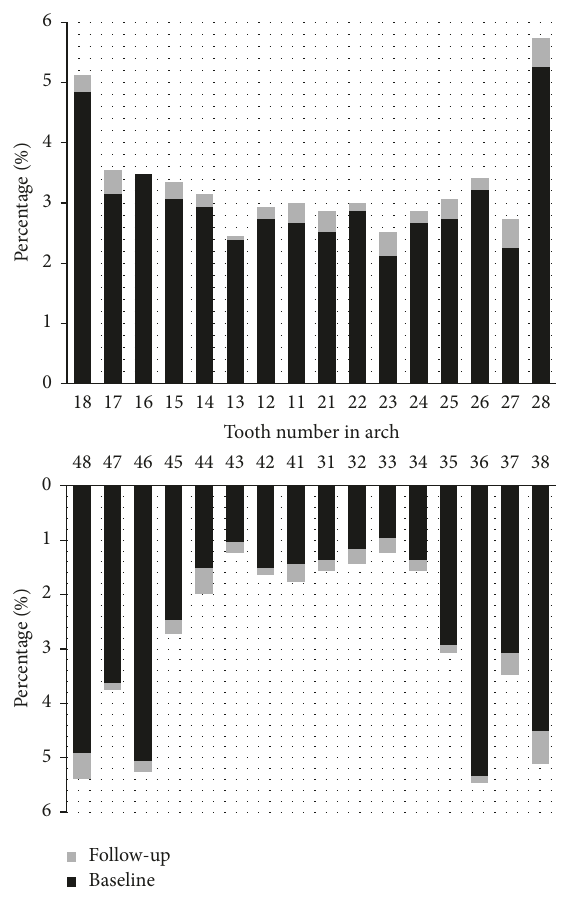
Figure 2: Percentage of tooth loss according to affected teeth in adults at the baseline and follow-up. Piracicaba, S˜ao Paulo, Brazil,